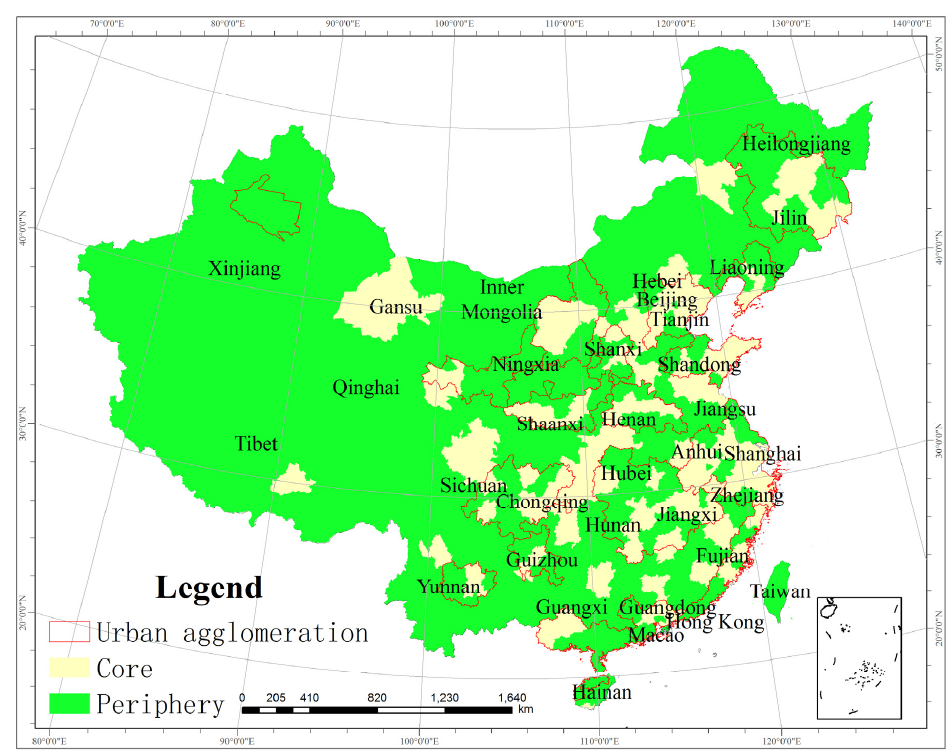
Figure 6. Core–periphery areas of the tourism information flows in